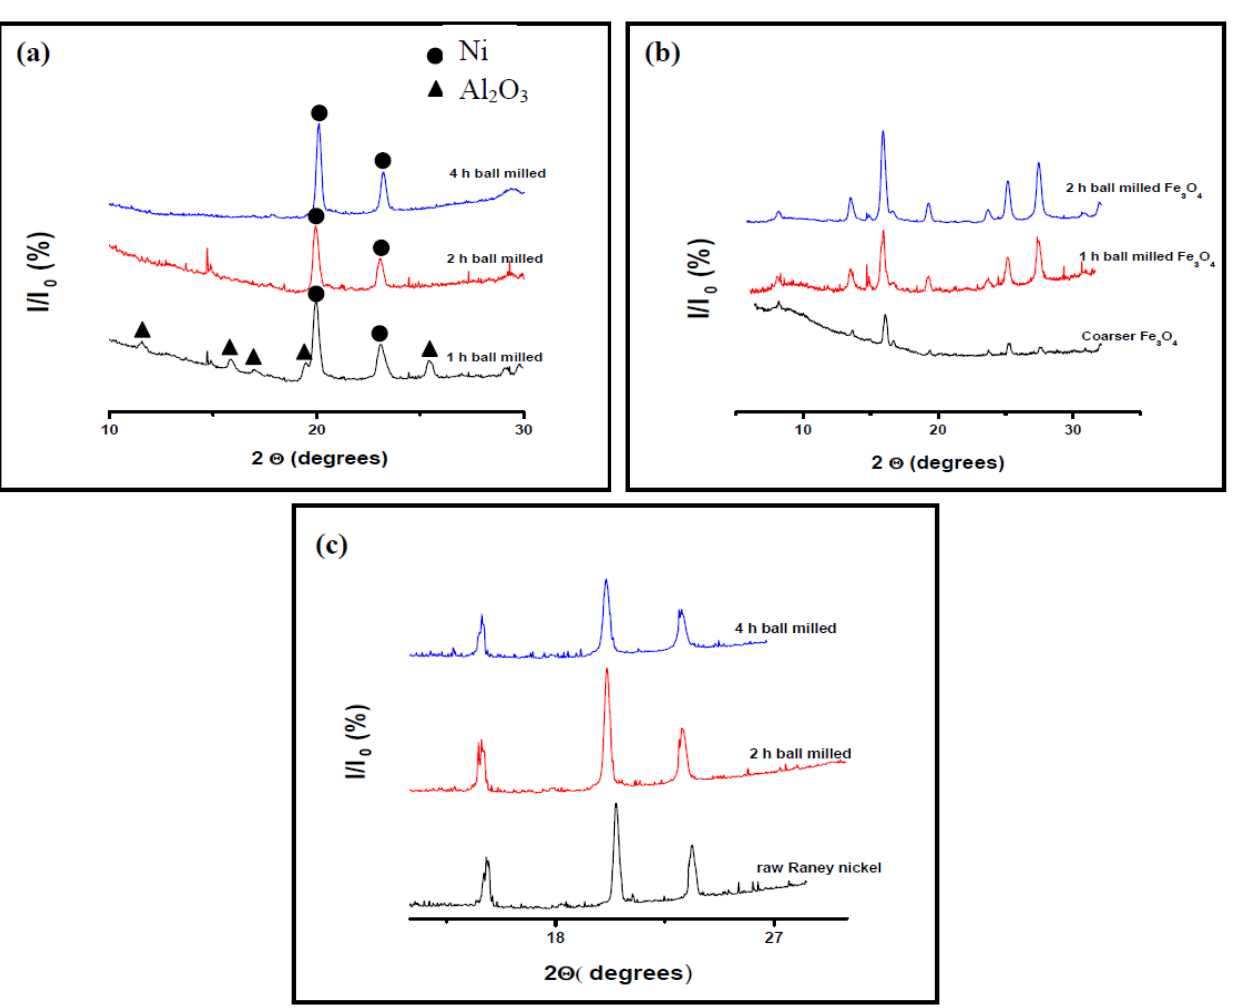
Figure 1. XRD Pattern for variously ball milled ( a ) Al